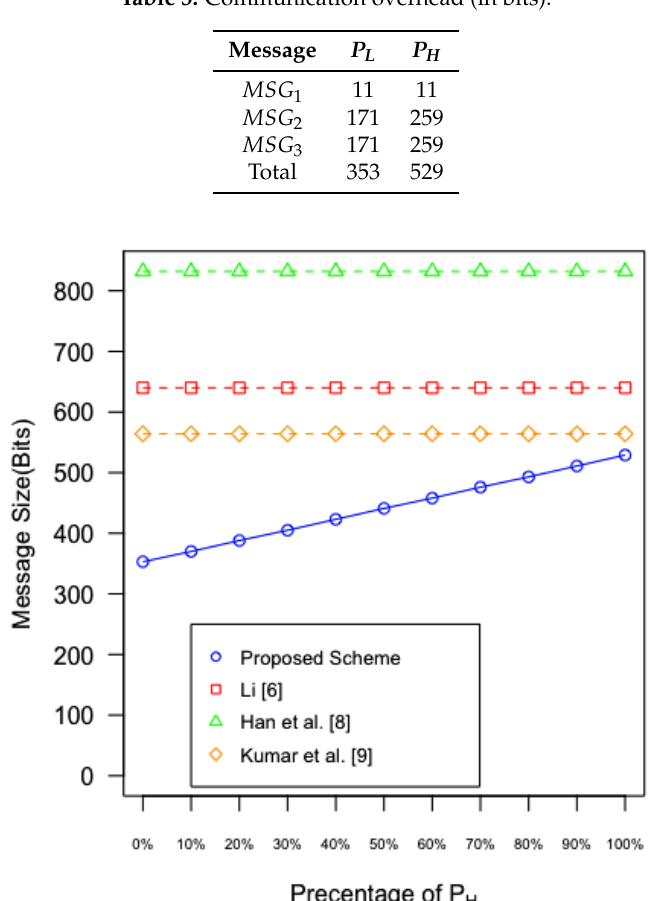
Table 3. Communication overhead (in bits).